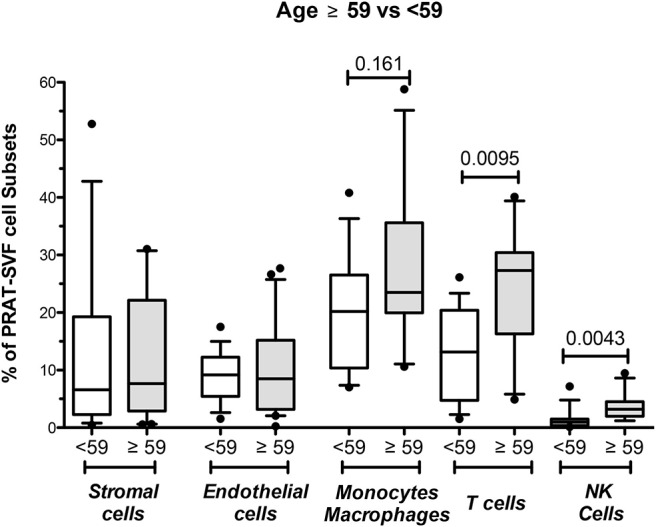
Analysis of perirenal adipose tissue stromal vascular fraction (PRAT-SVF) in young vs. aged donors. PRAT-SVF was analyzed according to donor age when stratified in aging donors (≥59 years, n = 29) and younger donors (<59 years, n = 24). Percentages in stromal and endothelial cells were not different between the aging and younger donors. However, the aging donors presented a trend for increased representation of the CD45+ CD14+ monocyte macrophage cell subset and a significantly higher percentage of T and NK cells.